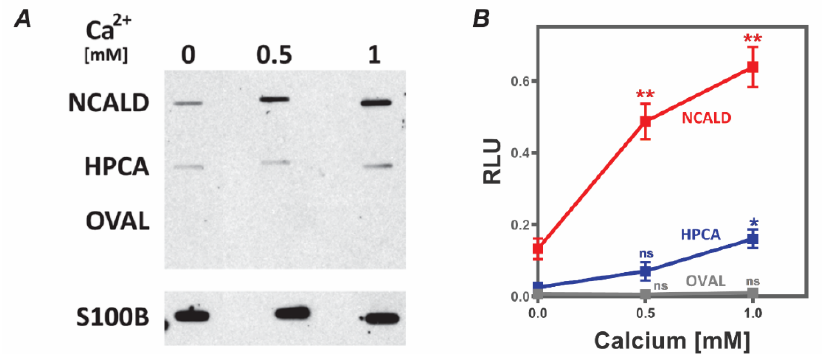
Figure 1. NCALD binds to S100B in vitro: Purified neurocalcin delta (NCALD), hippocalcin (HPCA) and commercial ovalbumin (OVAL) were blotted onto nitrocellulose and the membrane was then incubated with S100B in the presence of indicated concentrations of CaCl 2 . After 1 h incubation, the blot was washed with buffer. Bound S100B was detected using its antibody following standard Western blotting protocol and ECL detection. ( A ) A representative blot. ( B ) Data provided was collected from at least five independent experiments with three different preparations of the proteins. Intensity for each band was measured over the background using imageJ and then plotted (mean ± SEM) as relative luminescence unit (RLU) in Prism (9.0). Student’s t -test was carried out for each protein to determine significance compared to values obtained at 0 mM calcium. ns p > 0.01; * p ≤ 0.05; ** p ≤ 0.01.